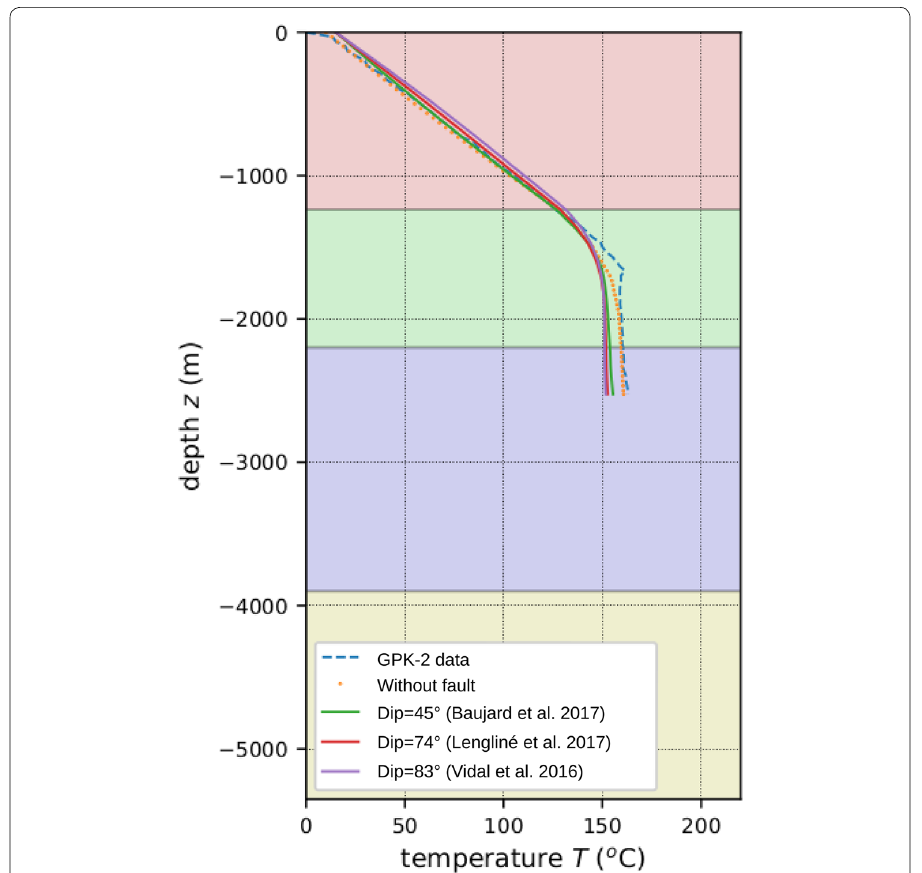
Fig. 7 Simulated temperature–depth profiles obtained at the maximum ascending flow profile from models including the Rittershoffen fault with different dips and compared to the model without